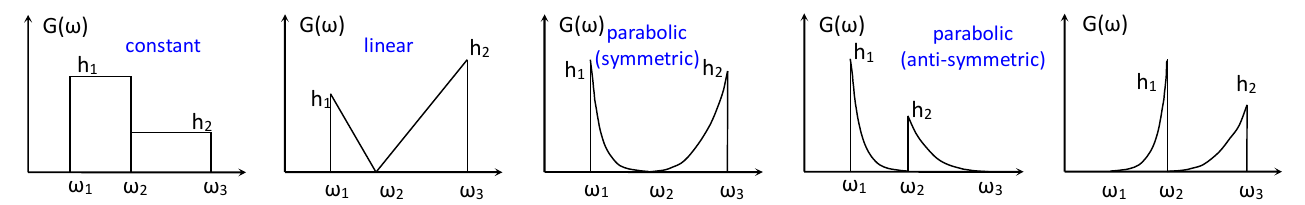
Figure 5. Power spectral densities used in simulations to calibrate weight (cid:1875) (cid:2870) in TB method. Soon after [16] was published, a further attempt was made in [17] to correlate (cid:1875) to fractional order spectral moments (cid:1865) (cid:2868).(cid:2875)(cid:2873) and (cid:1865) (cid:2869).(cid:2873) (in bandwidth parameter (cid:2009) (cid:2868).(cid:2875)(cid:2873) ) by the